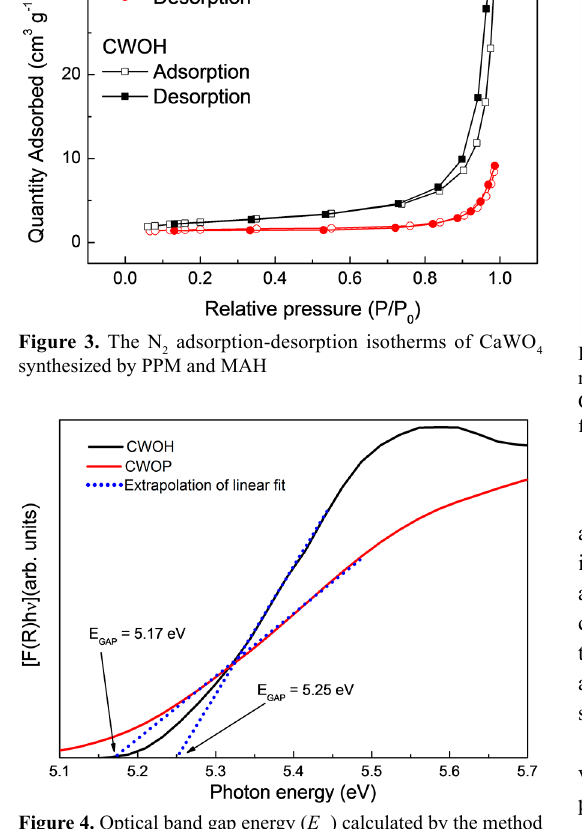
Figure 4. Optical band gap energy ( E proposed by Kubelka - Munk for any wavelength of CaWO synthesized by MAH and PPM